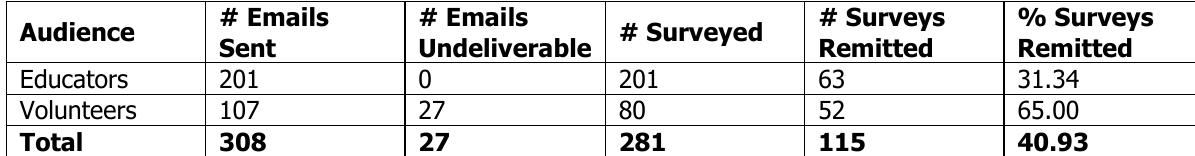
Summary of survey response rage